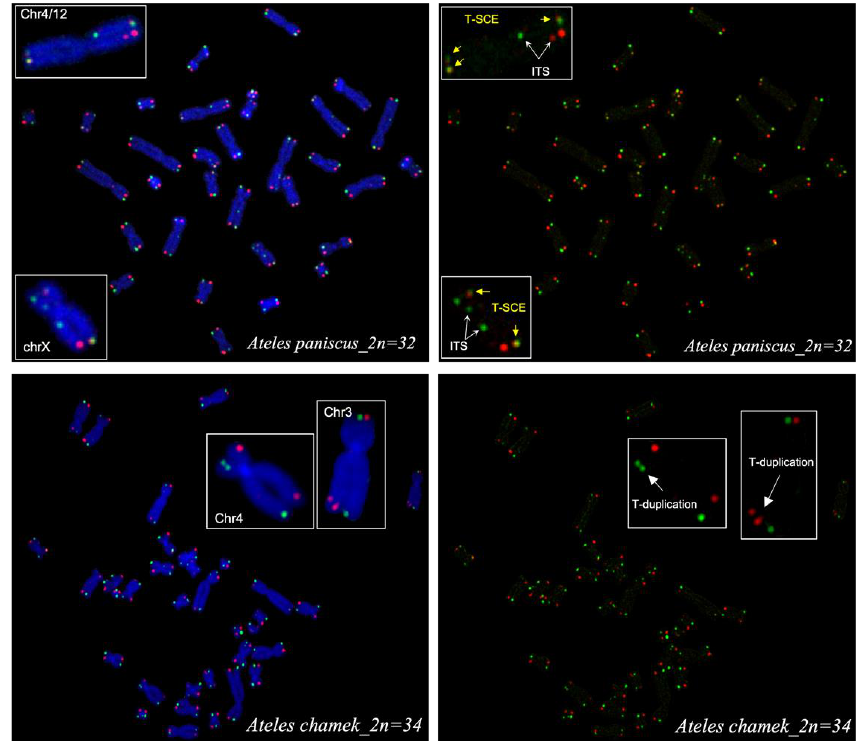
Figure 6. A. paniscus and A. chamek CO-FISH: Images showing leading (red) and lagging (green) strand telomeres. Metaphase chromosomes counterstained with DAPI (blue) and without. Telomeric- sister chromatid exchanges (T-SCEs), interstitial telomeric sequences (ITSs), and telomere duplications are